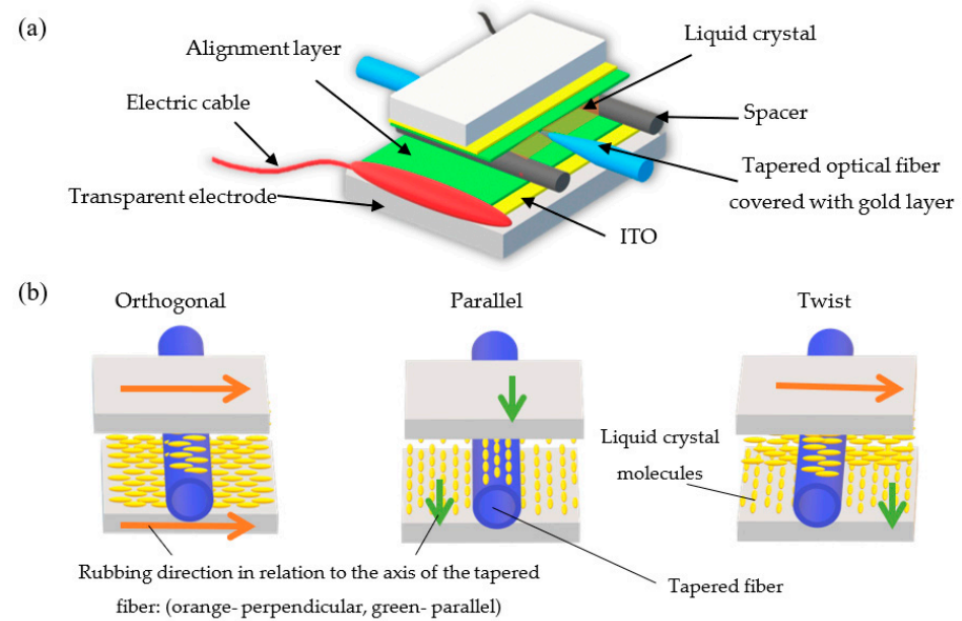
Figure 4. Scheme of the: ( a ) liquid crystal (LC) cell and ( b ) types of the investigated cells: orthogonal, parallel, and